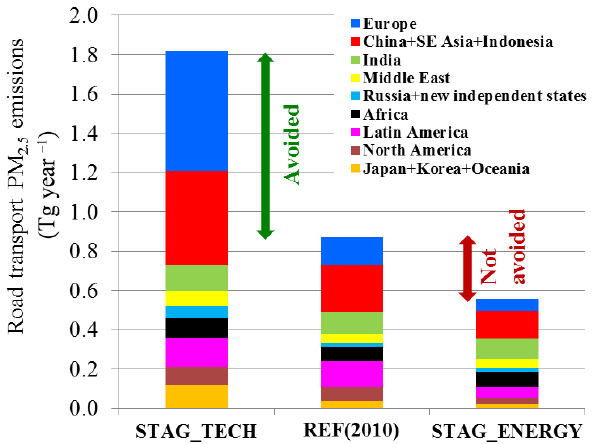
Figure 8. Regional contributions to PM 2 . 5 road transport emissions in 2010 for the STAG_TECH, REF and STAG_ENERGY scenarios. The green arrow (STAG_TECH minus REF) indicates the amount of emissions avoided by the combination of legislation and techno- logical advancements, and the red arrow (REF minus STAG_ EN- ERGY) the additional emissions associated with increased energy use between 1970 and